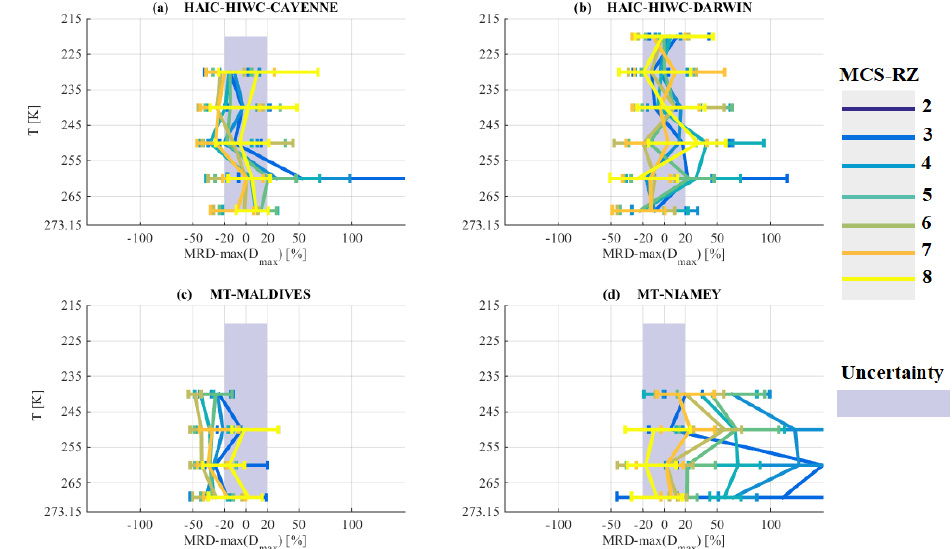
Figure 18. The same as Fig. 6 but for maximum size of hydrometeors max (D max )